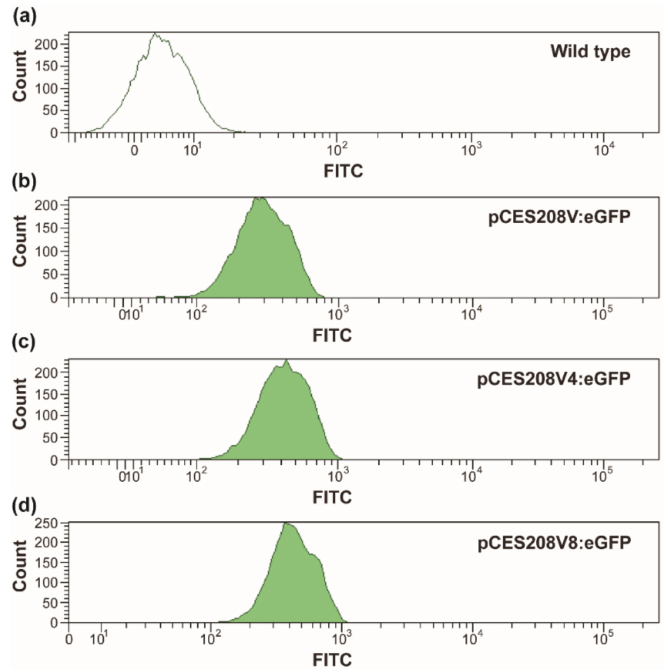
Figure 2. The fluorescence intensity of the recombinant EGFPV1 ( b ), EGFPV4 ( c ), and EGPV8 ( d ) strains after 24 h of cultivation. The wild type strain, C. glutamicum KCTC 1857 ( a ) was used as negative control. 2.2. 5-AVA Production Using Recombinant C. glutamicum with Tunable P vgb